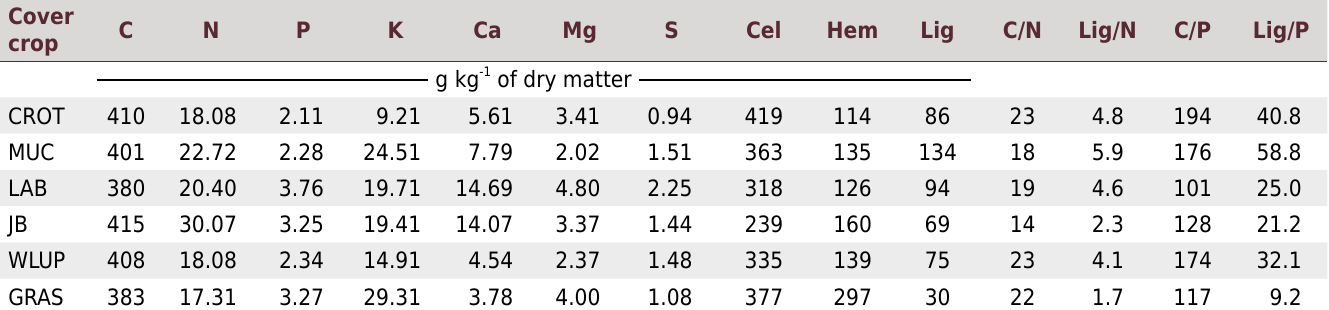
Table 1. Nutrients, cellulose (Cel), hemicellulose (Hem), and lignin (Lig) contents and C/N, Lig/N, C/P, and Lig/P ratios of shoot phytomass from different cover crops at 93 days after planting Cover crop